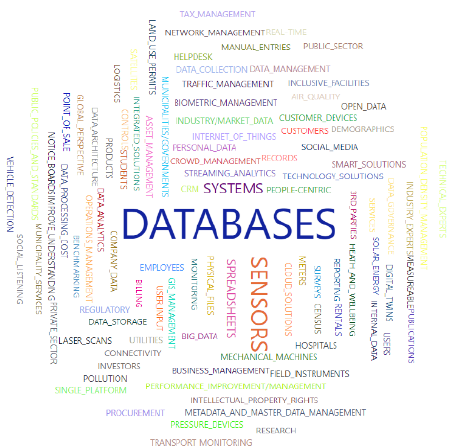
Figure 8 . Smart City Data sources